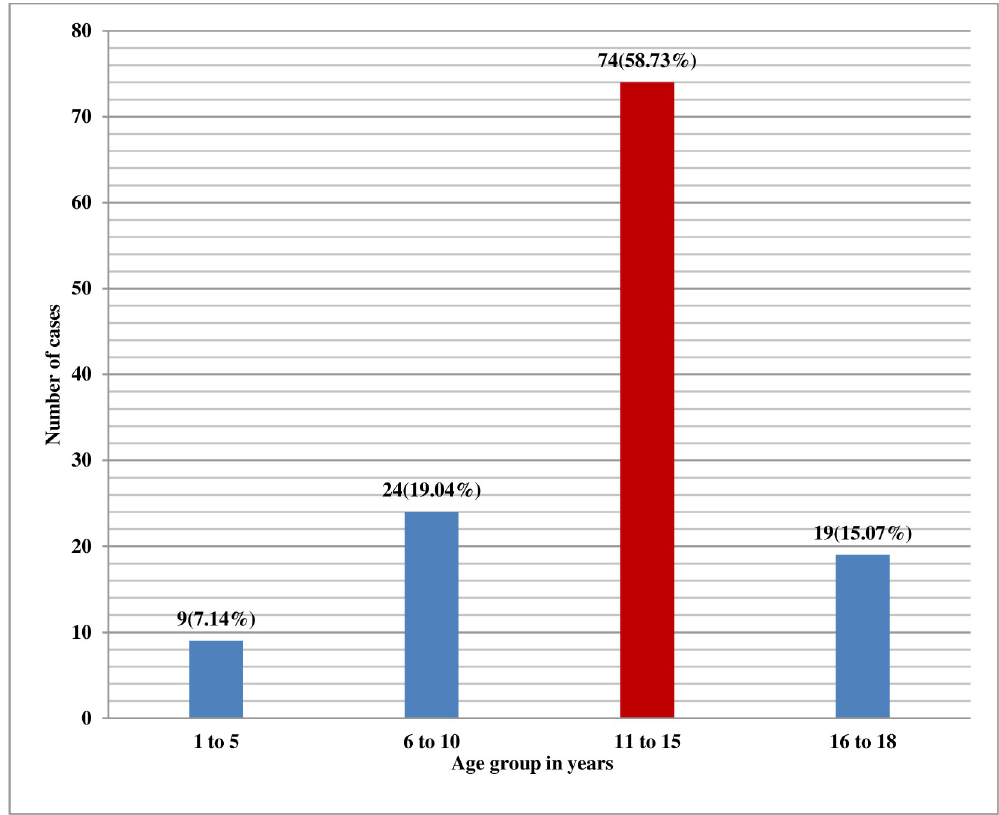
Fig 1. Age distribution of paediatric kidney patients (N =